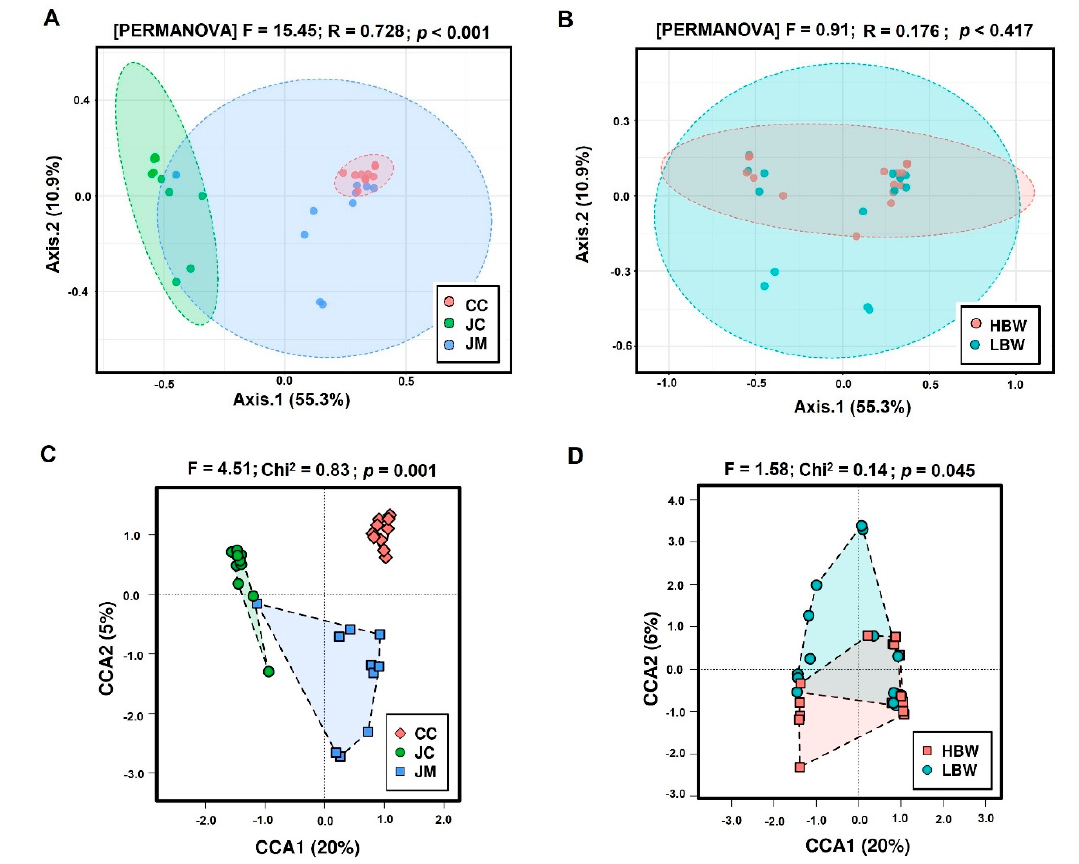
Figure 1. Principal coordinate analysis (PCoA) based on Bray–Curtis dissimilarity matrix on samples: ( A ) ordination of sampling places (JC, JM, and CC); ( B ) ordination of BW groups. Significance was examined with permutational multivariate analysis of variance (PERMANOVA) performed with 999 permutations. The differences were considered significant at a level of p < 0.05. ( C ) Canonical correspondence analysis (CCA) of gut microbiota clustering according to sample sites and ( D ) BW groups. Legend: JC—jejunum chymus in green; JM—jejunum mucosa in blue; CC—caecum chymus in red; LBW—low body weight; HBW—high body weight.